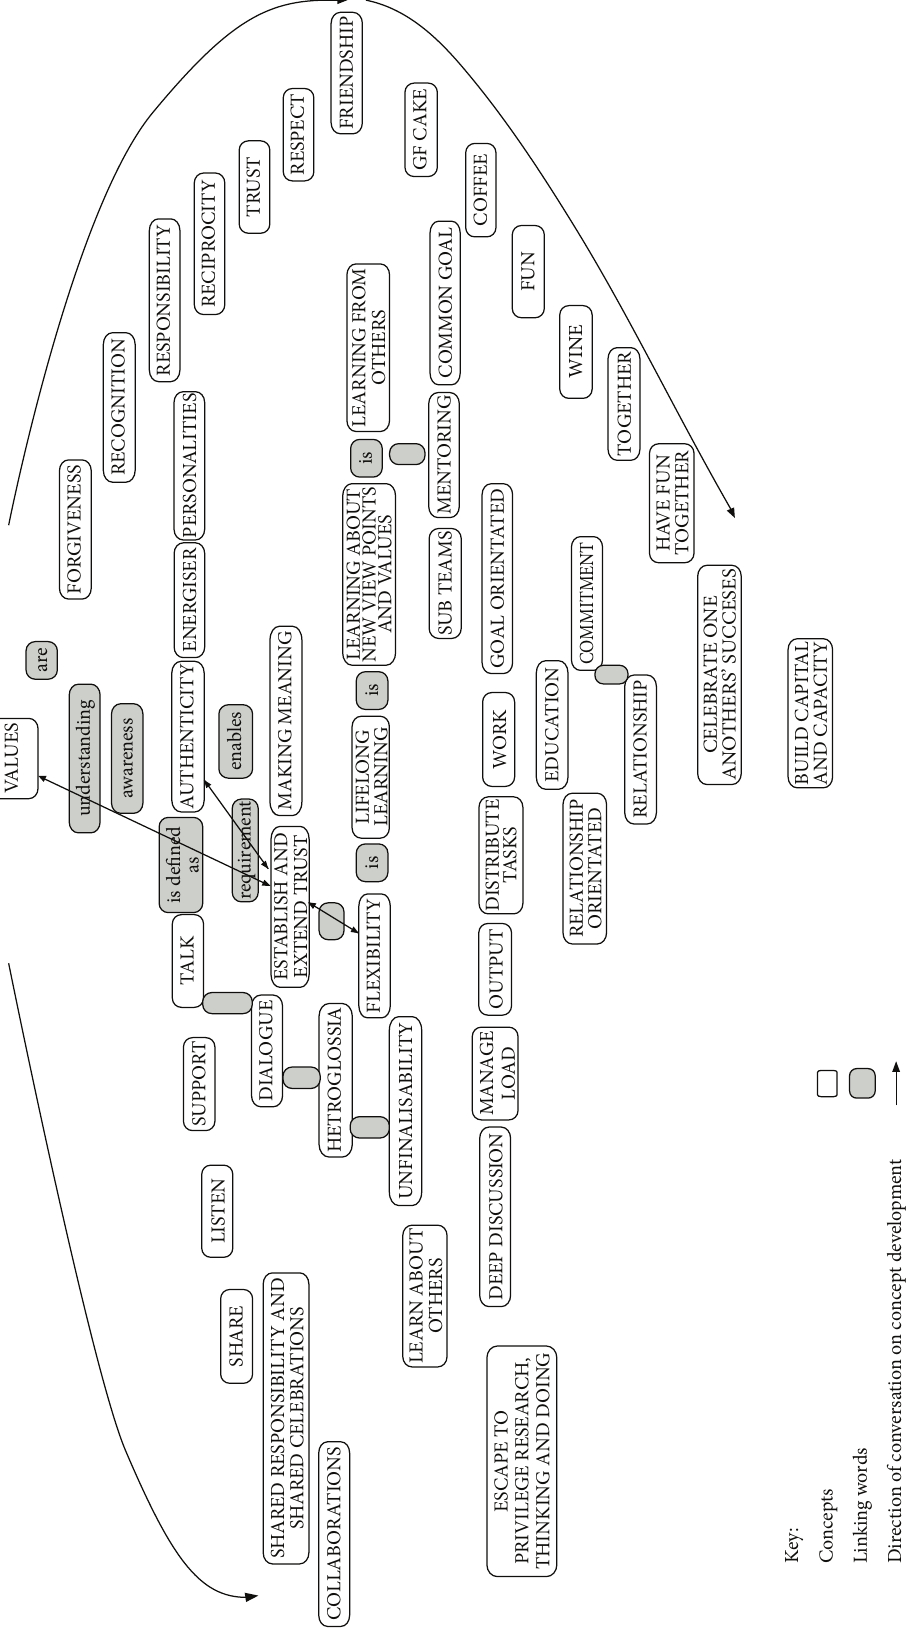
Figure 1: The first collaborative concept map produced by the research team. From “Collaborative concept mapping: an education research team leveraging their collaborative efforts” [14, page 66]. Reproduced and adapted with permission of